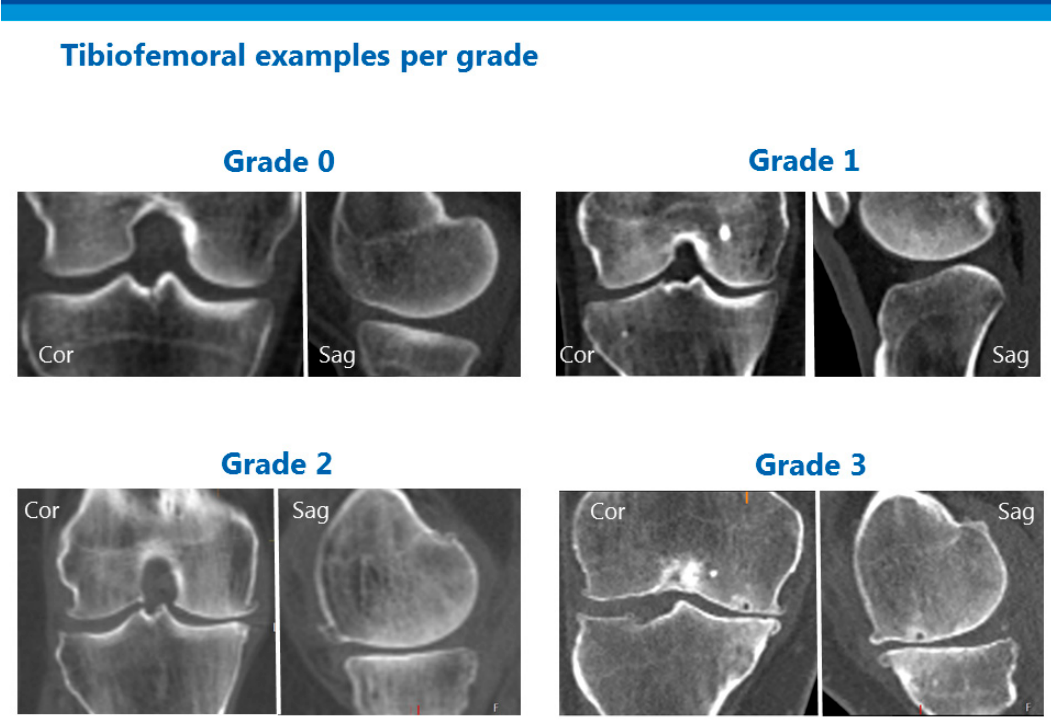
Figure 1. Examples of the different scores of osteoarthritis for the tibiofemoral joint. Sag (Sagittal), Cor (Coronal).